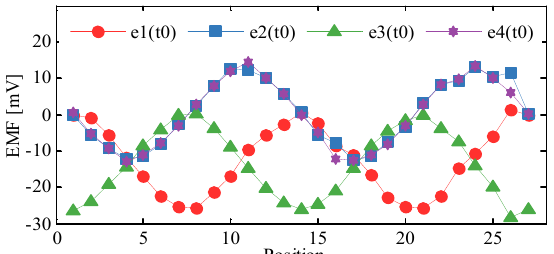
Figure 6. Comparison of EMFs vary with displacements at t 0 =250 μs.